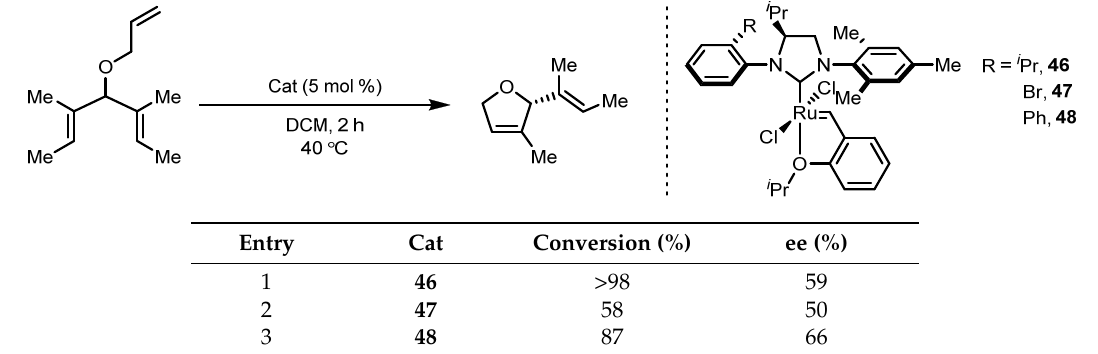
Table 13. Employment of unsymmetrical NHC ligands in ARCM by Blechert and coworkers.